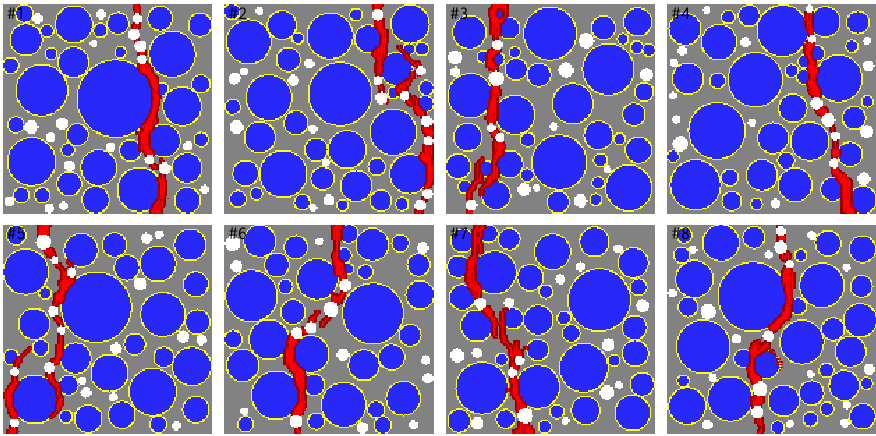
Figure 20. Crack pattern for selected specimens with P pore = 4% and P agg = 40%.